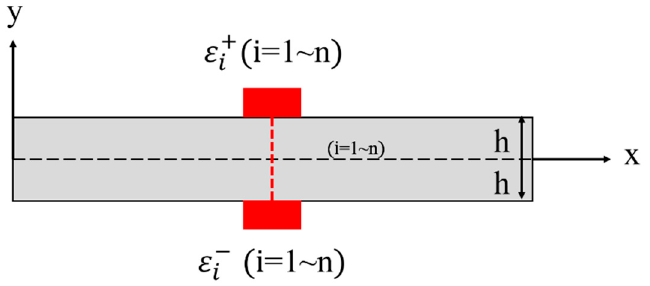
Figure 3. Discrete surface strain measured by strain sensors within two-node inverse-beam element. The inverse finite element is based on the least squares variational principle to